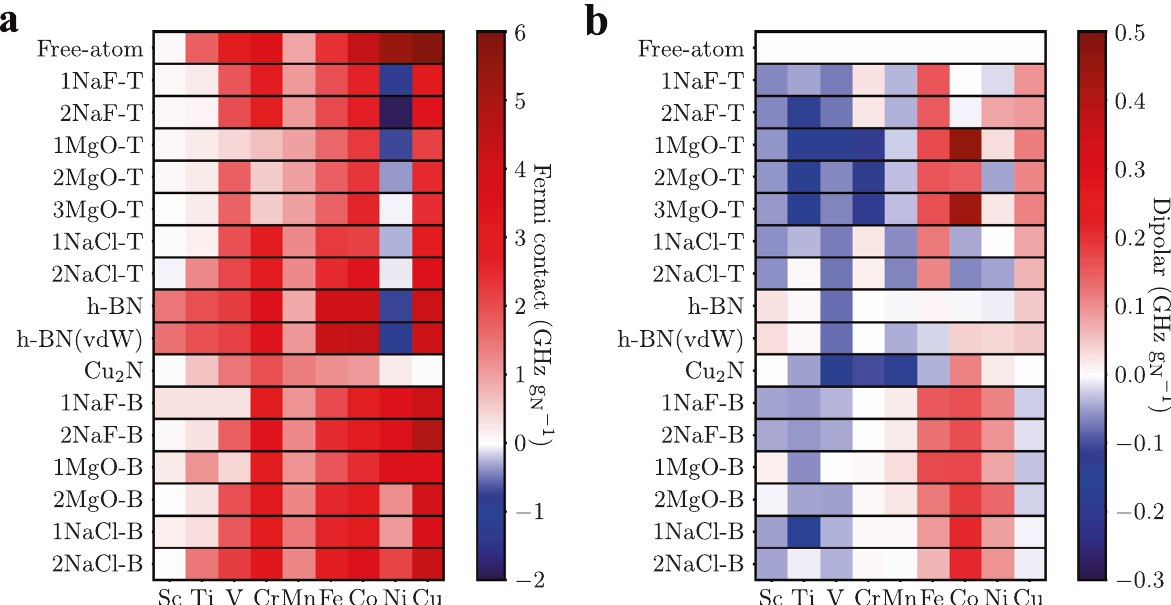
Fig. 1 Hyper fi ne interactions of magnetic adatoms on ultrathin fi lms. a Fermi contact and b dipolar contributions. The free-atom values are given for comparison. The number to the left in the legend indicates the number of layers in the fi lm. The adsorption position is denoted with T for atop the anion and with B for the bridge position (for h--BN and Cu 2 N only T was considered). The possible impact of corrections from van der Waals interactions was explored for the h--BN